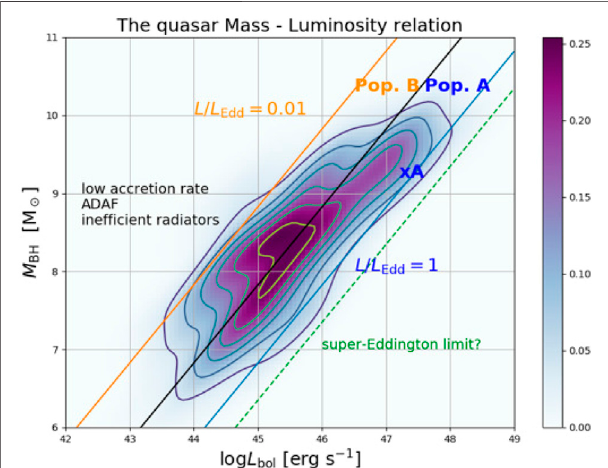
FIGURE 15 | Mass-luminosity relation for a sample of ≈ 330 AGNs, made of 280 low- z quasars from Marziani et al. (2003) and high-luminosity 50 HE quasars of the sample described by Sulentic et al. (2004). The diagonal linestrace thelower ∼ 0.01 · L / L Edd and ∼ 1.00 · L / L Edd . The wide majority of AGN is included within these